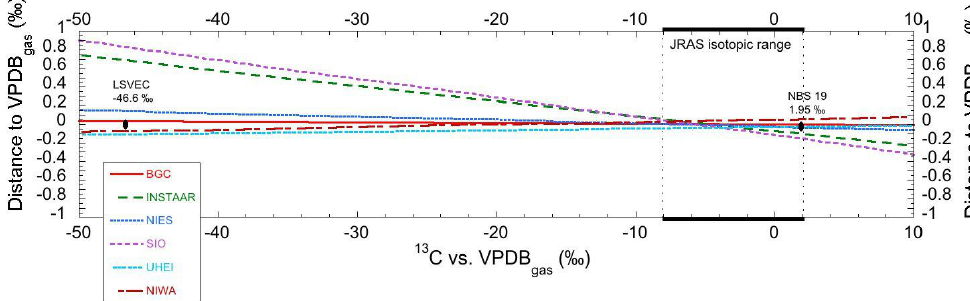
Figure 4. Extrapolation based on linear regression of the JRAS  13 C data Fig. 4. Extrapolation based on linear regression of the JRAS δ 13 C data.